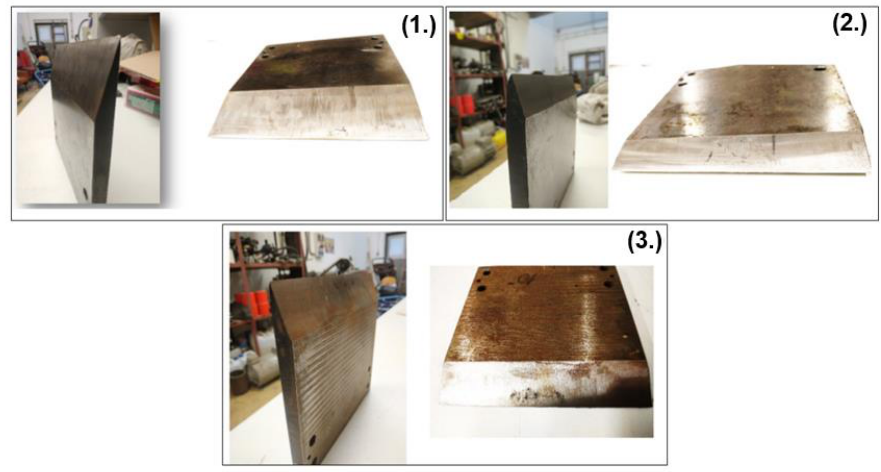
Figure 3. Delimbing knives in re-sharpened condition . Table 1 . Technical parameters of delimbing knives used in the experiment [17]. Knife No.